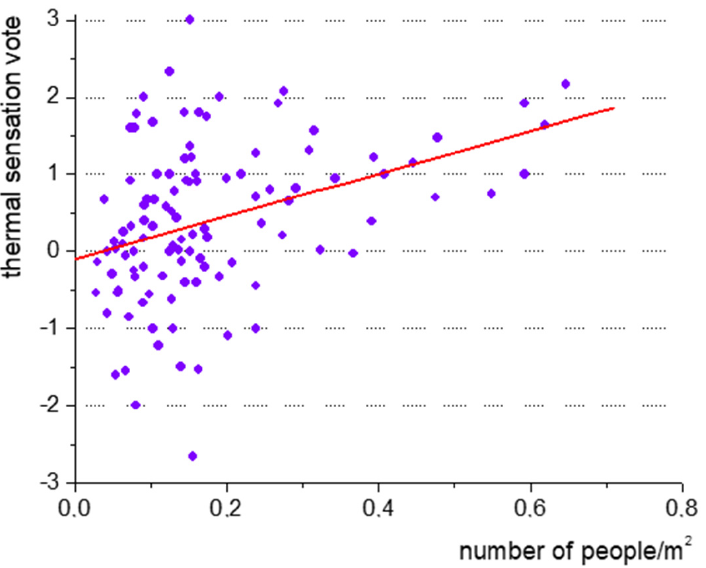
Figure 19. Thermal sensation vote vs. number of people per unit area, the red line represents the linear fitting, while the purple dots the average values of TSV.